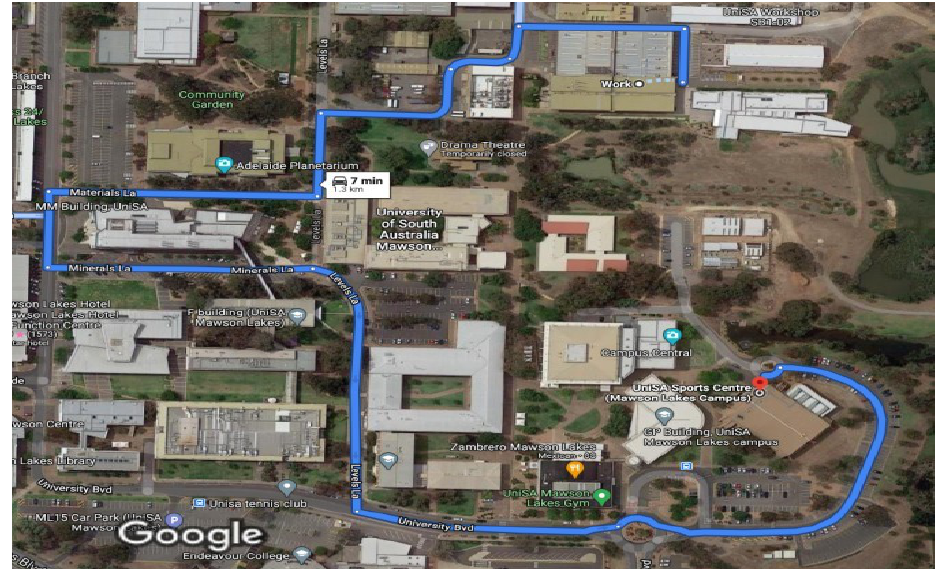
Figure 11. Real test